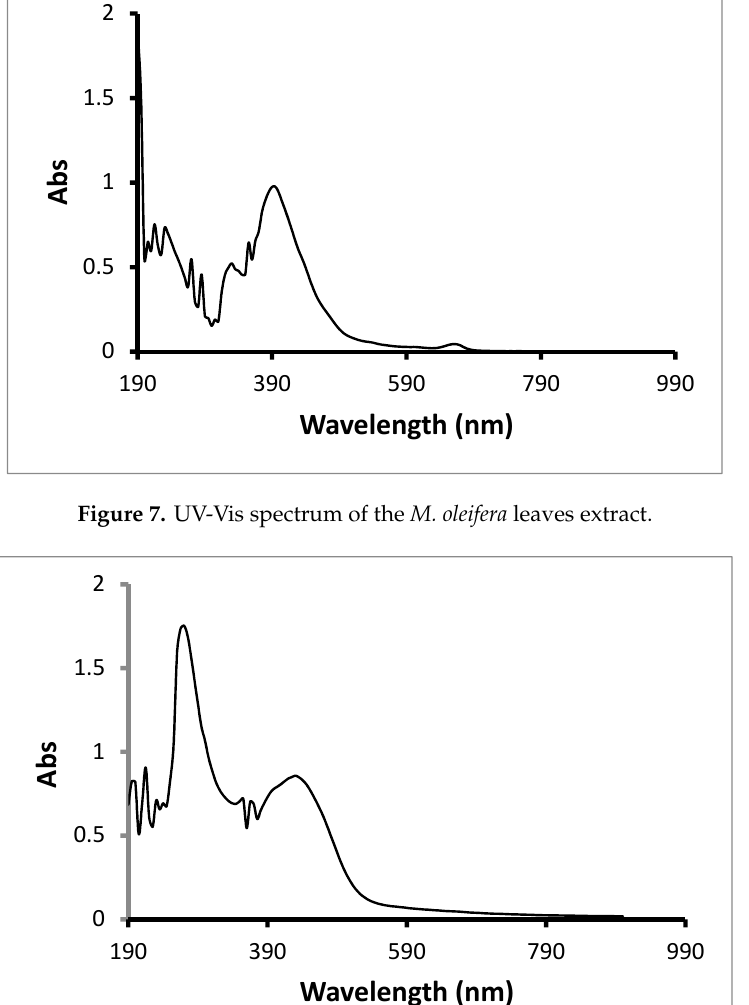
Table 3. Antioxidant activity percentage (AA%) using DPPH assay.